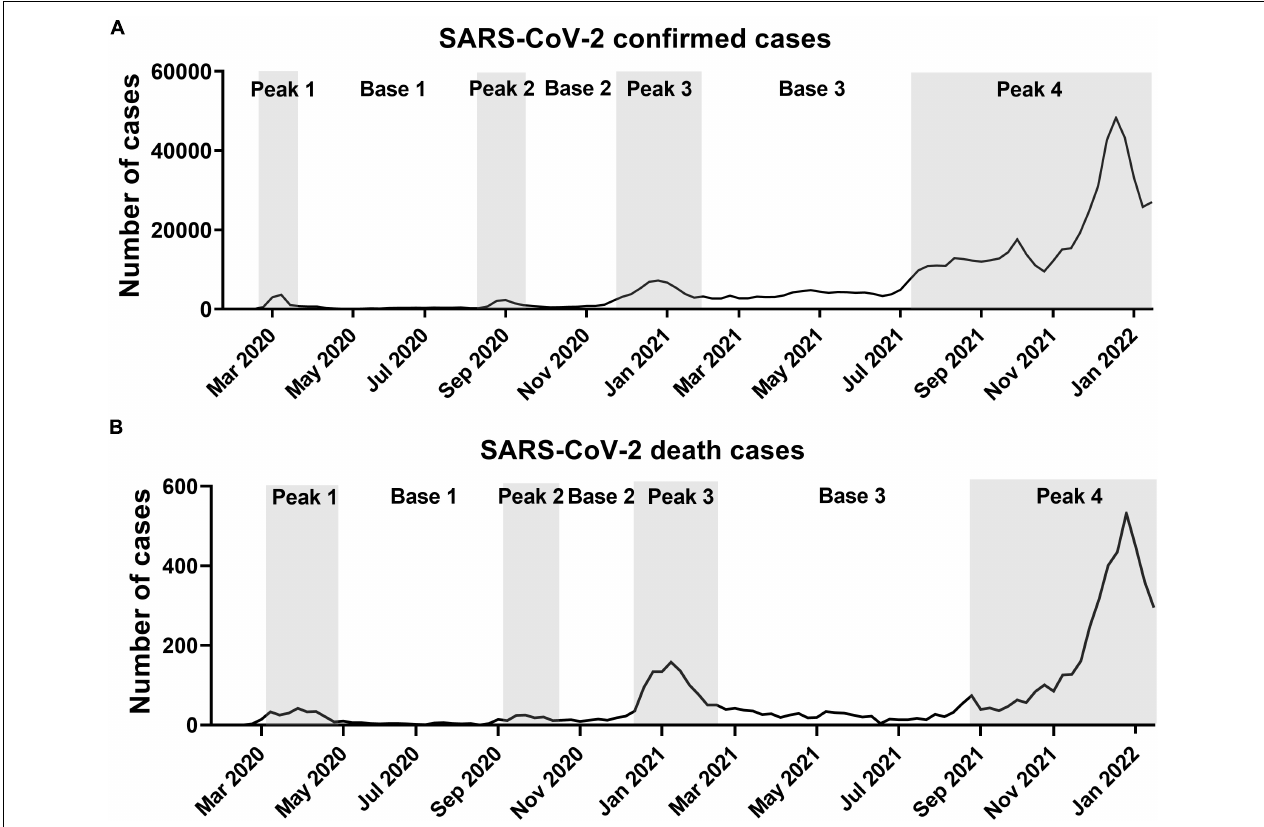
FIGURE 1 | Weekly confirmed cases and deaths due to SARS-CoV-2 in South Korea. (A) Weekly confirmed cases. (B) Weekly death cases. Data are from start of epidemic until January 15, 2022. Peak periods are shown in gray.